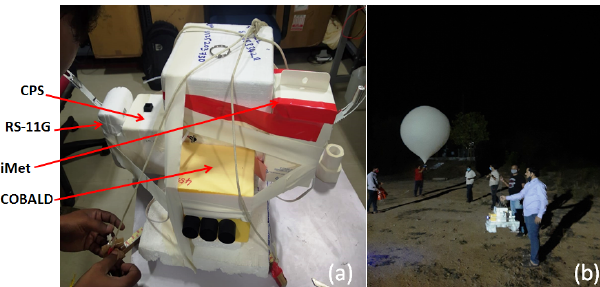
Figure 2. (a) The balloon payload with COBALD, iMet radiosonde, CPS, RS-11G radiosonde instruments attached. (b)